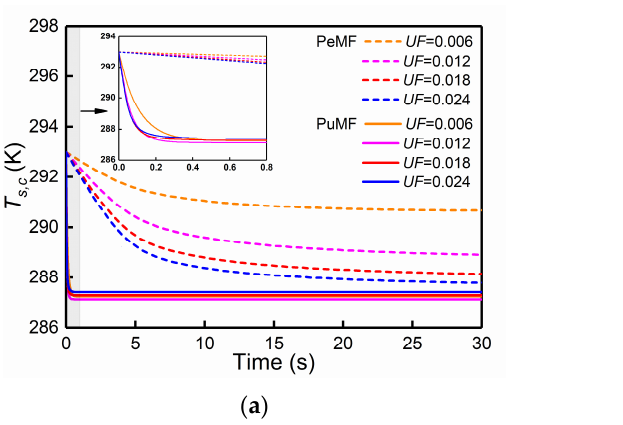
Figure 6. Transient variations of the cold ‐ end temperature T s,c and temperature difference Δ T CH under different UFs ( H = 1 T, Q ̇ c = 0 W, T h = T i = 293 K) ( a ) Cold ‐ end temperature; ( b ) yemperature difference.